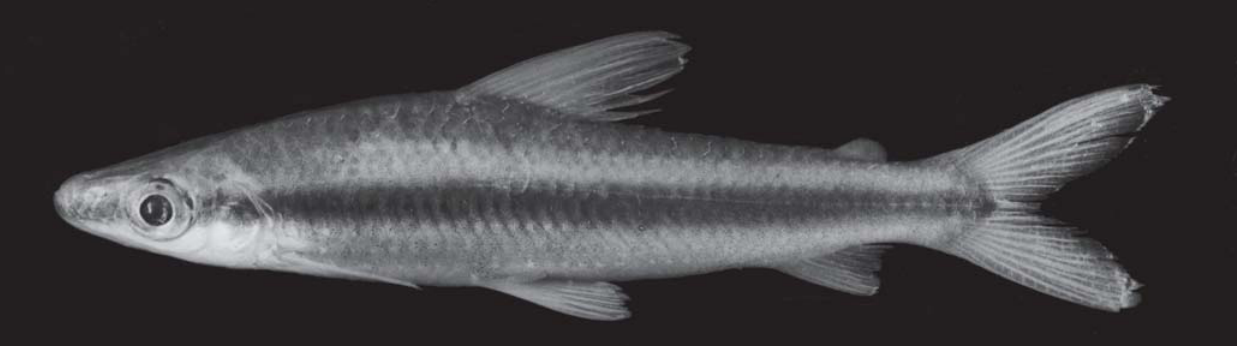
Fig. 18. Young of Laemolyta orinocensis , MHNLS 4231, 133.5 mm SL; Venezuela, Apure, Laguna, 2 km southeast of caño la Pica.